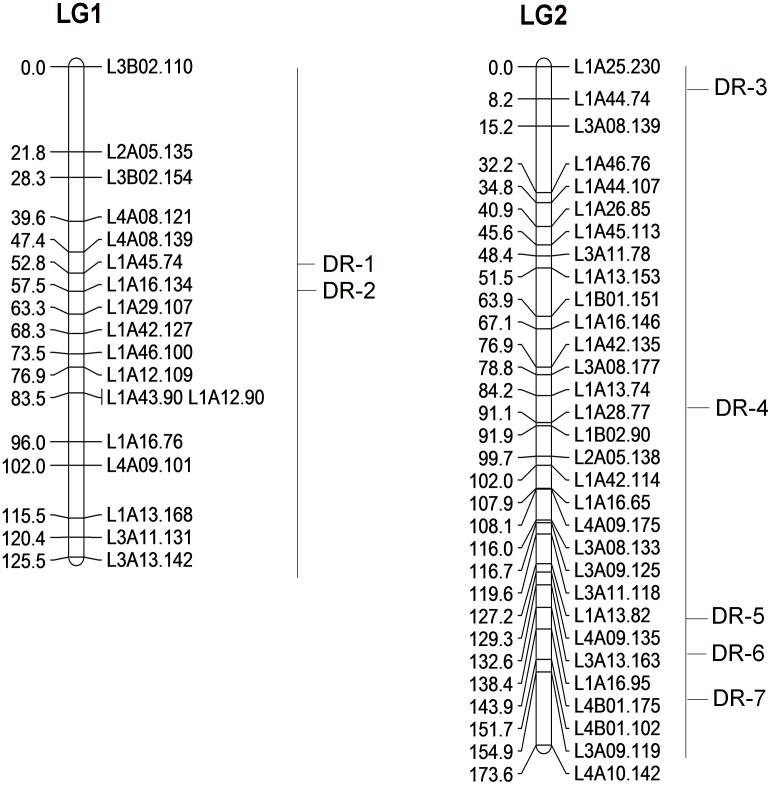
Putative QTLs for deltamethrin resistance in Culex pipiens pallens.The position of QTLs identified with composite interval mapping (CIM) are indicated as DR-1~DR-7 from LG1 and LG2.